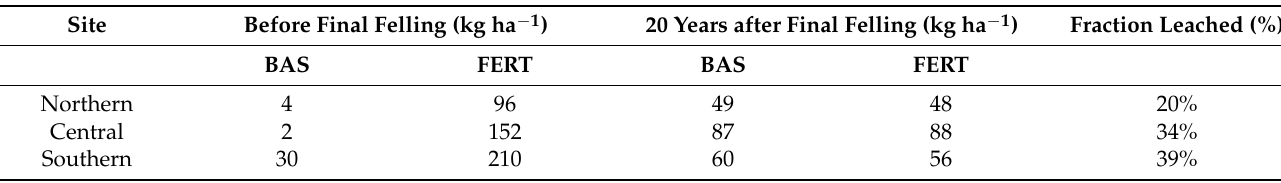
Table 6. Cumulative leaching for the BAS and FERT scenarios, from first fertilization to final felling and from final felling to 20 years after. The total N applied as fertilizer before final felling is equal to 450 kg ha − 1 .